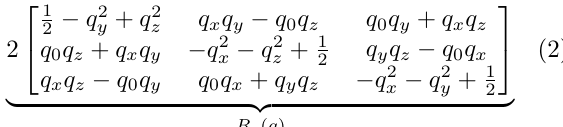
Figure 5: Experimental lab setup for VVMC in the Norwegian Motion Laboratory.